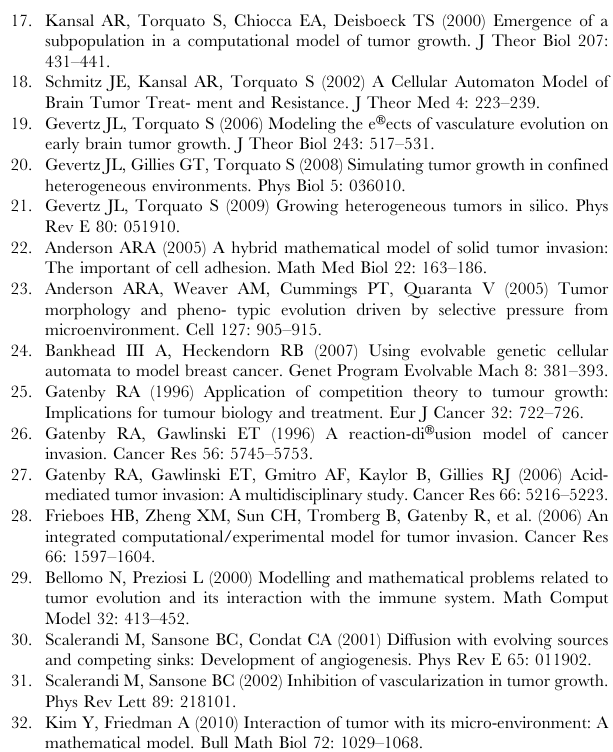
tumor volume. Therefore, invasive tumors plateau at a smaller size than the non-invasive tumor. (EPS) Figure S6 Evolution of a simulated invasive tumor with cellular motility m ~ 1 in the heterogeneous ECM with a sinusoidal-like density distribution. The mutation rate is c ~ 0 : 05 and ECM degradation ability is x ~ 0 : 9 . (a) Growing tumor on day 50. (b) Growing tumor on day 80. (c) Growing tumor on day 100. (d) Growing tumor on day 120. Note that the tumor morphology on days 80 and 120 are respectively shown in Figure 8(a) and (b) of the main paper. (TIF) Figure S7 Evolution of a simulated invasive tumor with cellular motility m ~ 3 in the heterogeneous ECM with a sinusoidal-like density distribution. The mutation rate is c ~ 0 : 05 and ECM degradation ability is x ~ 0 : 9 . (a) Growing tumor on day 50. (b) Growing tumor on day 80. (c) Growing tumor on day 100. (d) Growing tumor on day 120. Note that the tumor morphology on days 80 and 120 are respectively shown in Figure 8(c) and (d) of the main paper.